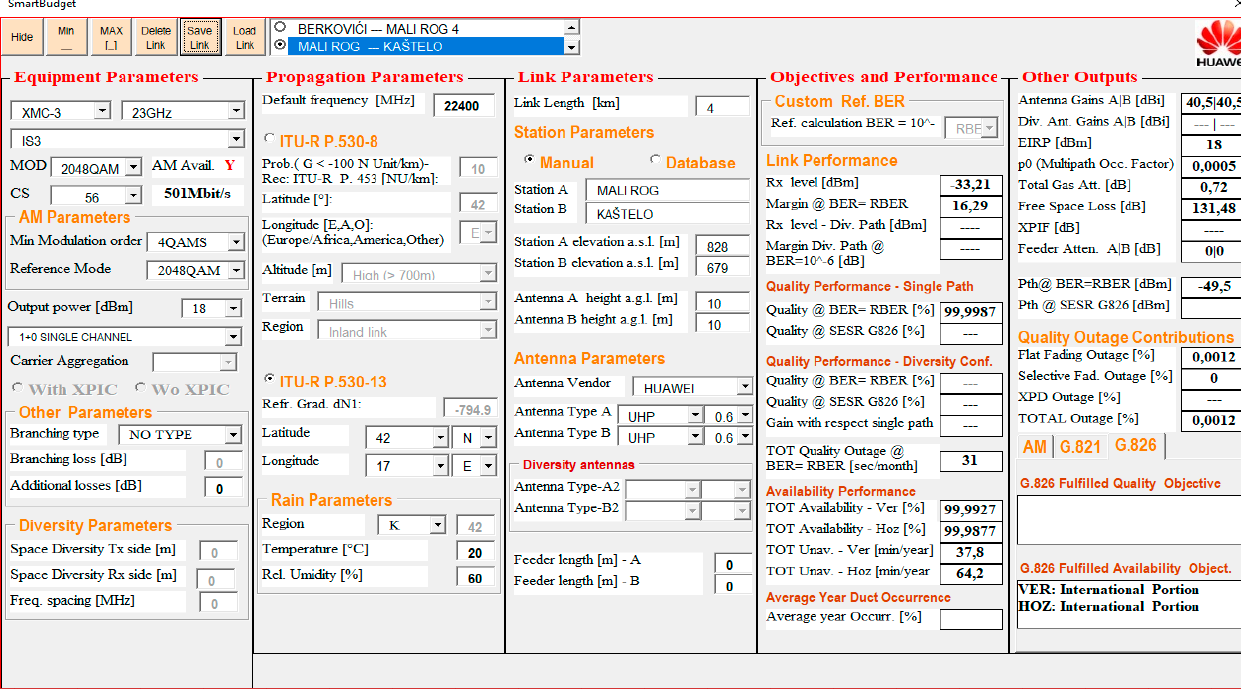
Figure 9. Prediction for the fourth RR section; 2048 QAM, 500 Mb/s.